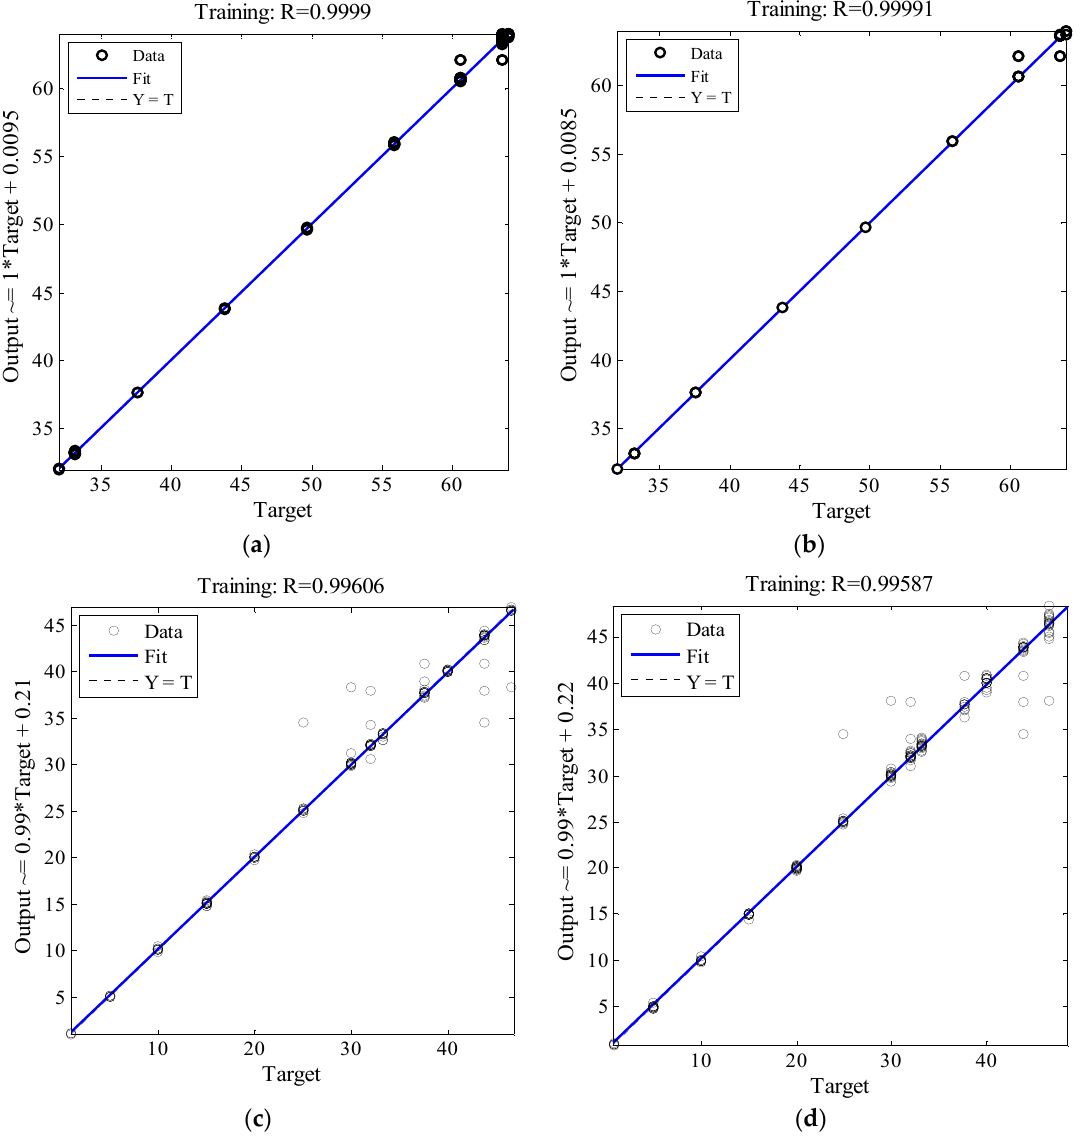
Figure 17. The performance of the hybrid GSA-ANN algorithm for ( a ) testing and ( b ) validation data for the outdoor velodrome and ( c ) testing and ( d ) validation for the indoor velodrome.